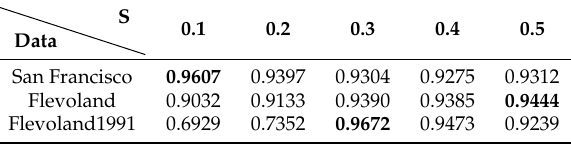
Table 4. OA under different values of parameter